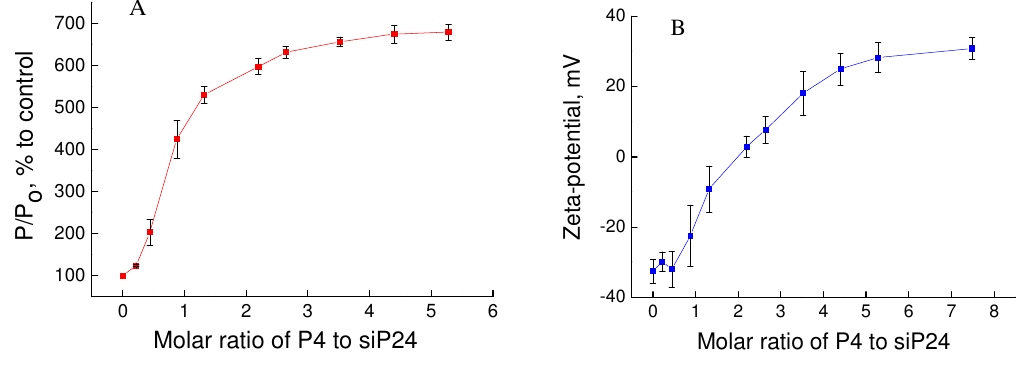
Figure 5. The zeta-size of the dendriplex between P4 and